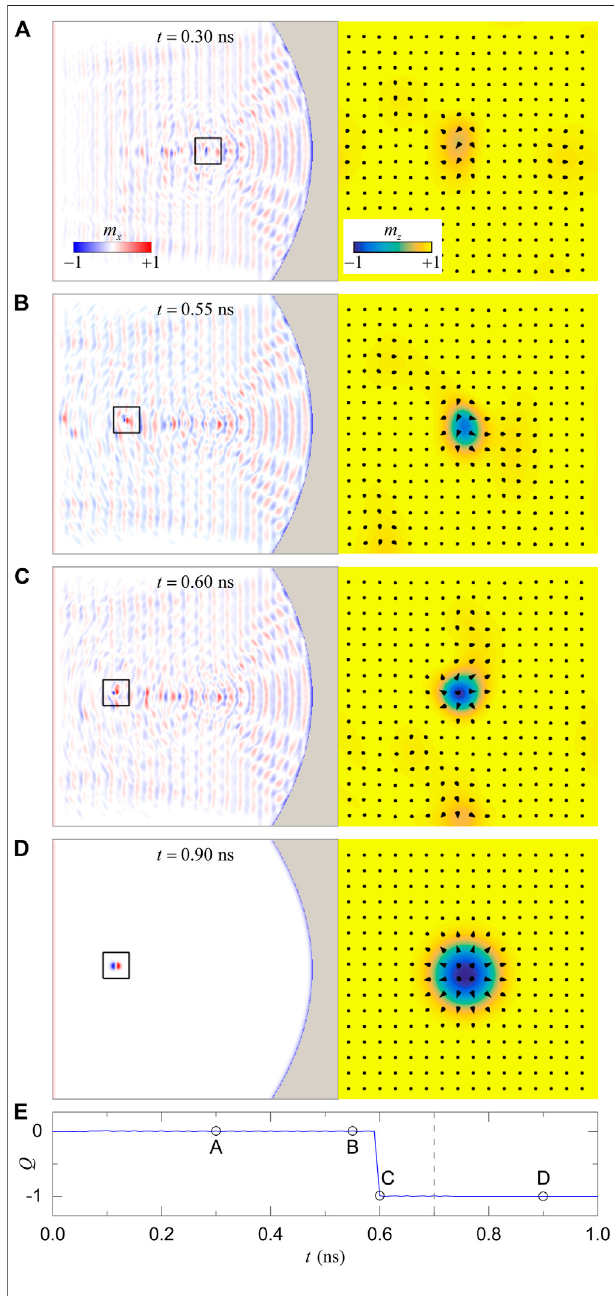
FIGURE 3 | The creation process of the magnetic skyrmion induced by the total-re fl ection focusing. The exciting fi eld with μ 0 h 0 (cid:2) 360 mT is applied in (A – C) and is turned off in (D) . The z-component magnetization of the rectangular area in the left column is enlarged in the right column. (E) Temporal evolution of the topological number Q . The microwave fi eld starts at t (cid:2) 0 and ends at t (cid:2) 0.7 ns, indicated by the gray dashed line. because the fi rst nucleated droplet driven by spin waves moves faster than the skyrmion during which the transformation from the droplet to skyrmion happens. This would lead to the skyrmion nucleation site developing far away from the focal point.